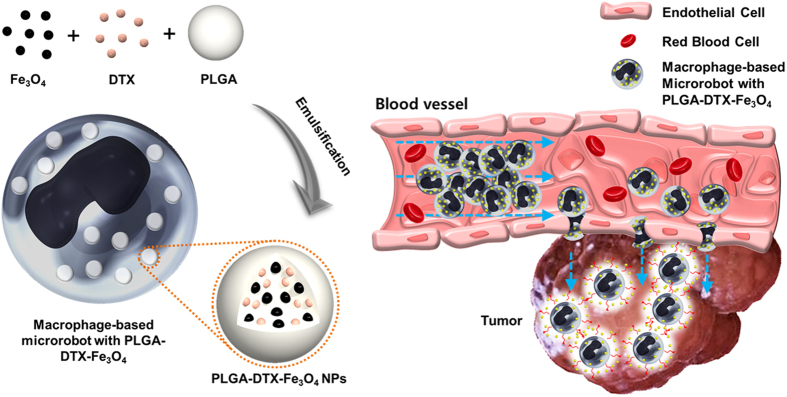
Development of macrophage-based microrobot and therapy.Schematic diagram of the macrophage-based microrobot with PLGA-DTX- Fe3O4 (left); depiction of possible tumor targeting and therapy in an in vivo environment (right).